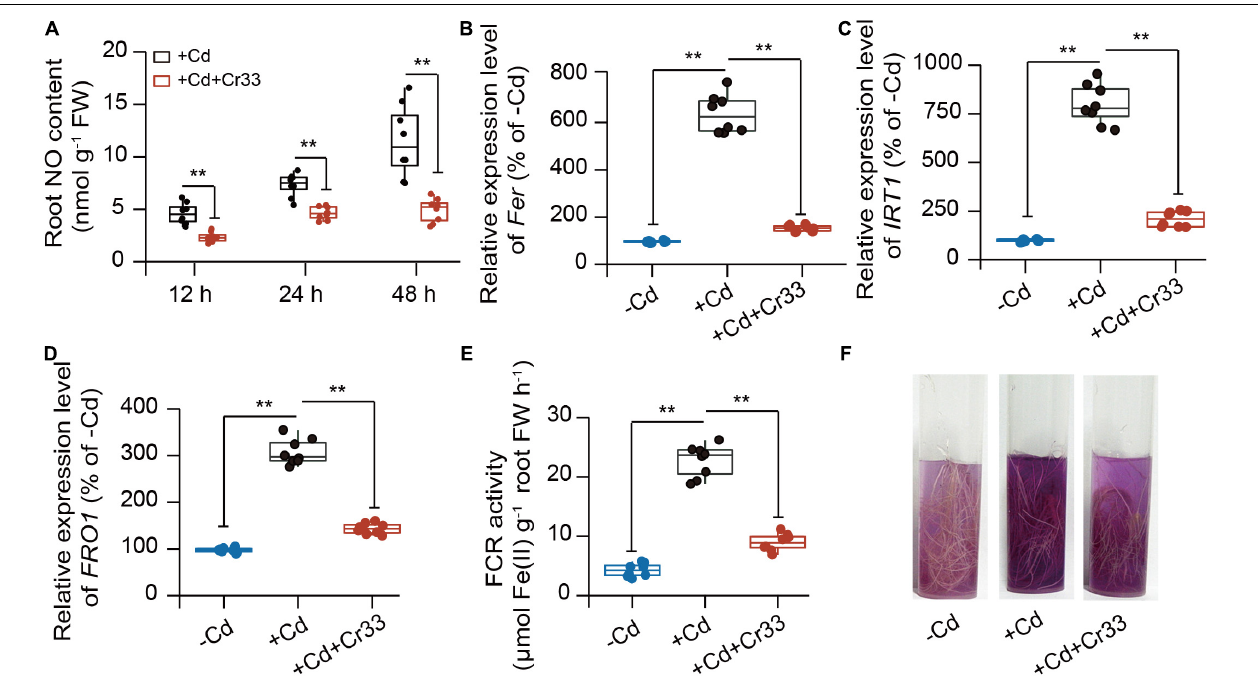
FIGURE 6 | Root inoculation with L. fusiformis Cr33 inhibited root Fe deficiency responses under Cd stress condition. Three-weeks-old tomato plants cultured in the split-root systems were inoculated with or without Cr33 for 3 d. Then, these plants were exposed to 100 µ M Cd with or without Cr33 for 48 h. These plants were used to analyze root No content (A) , the expression of Fer (B) , IRT1 (C) , FRO1 (D) . In addition, root FCR activities were quantified (E) and assessed by observing purple color (F) . Asterisks indicated significant differences between different experimental groups ( n = 8 biological replicates) using Student’s t -test (** p <